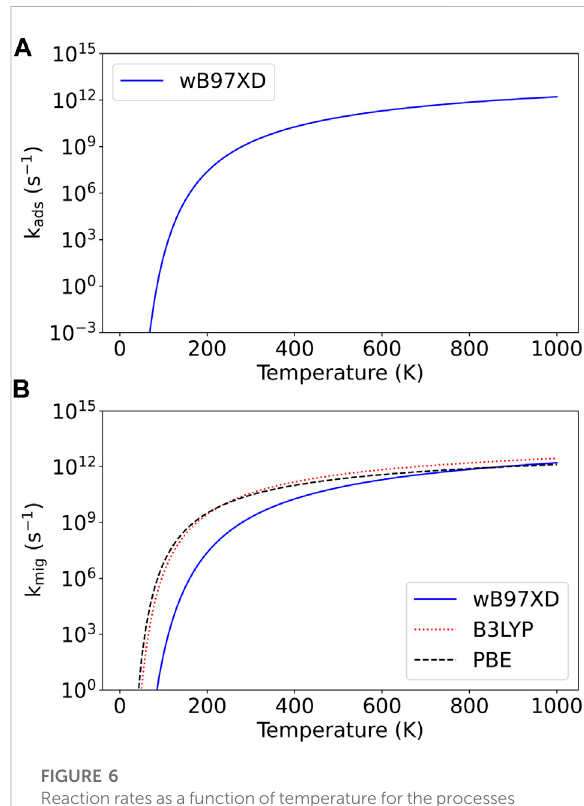
FIGURE 6 Reaction rates as afunction of temperature for theprocesses of (A) boron adatom adsorption on graphene and (B) migration of theboronadatombetweenadjacentbindingsitesonthegraphene